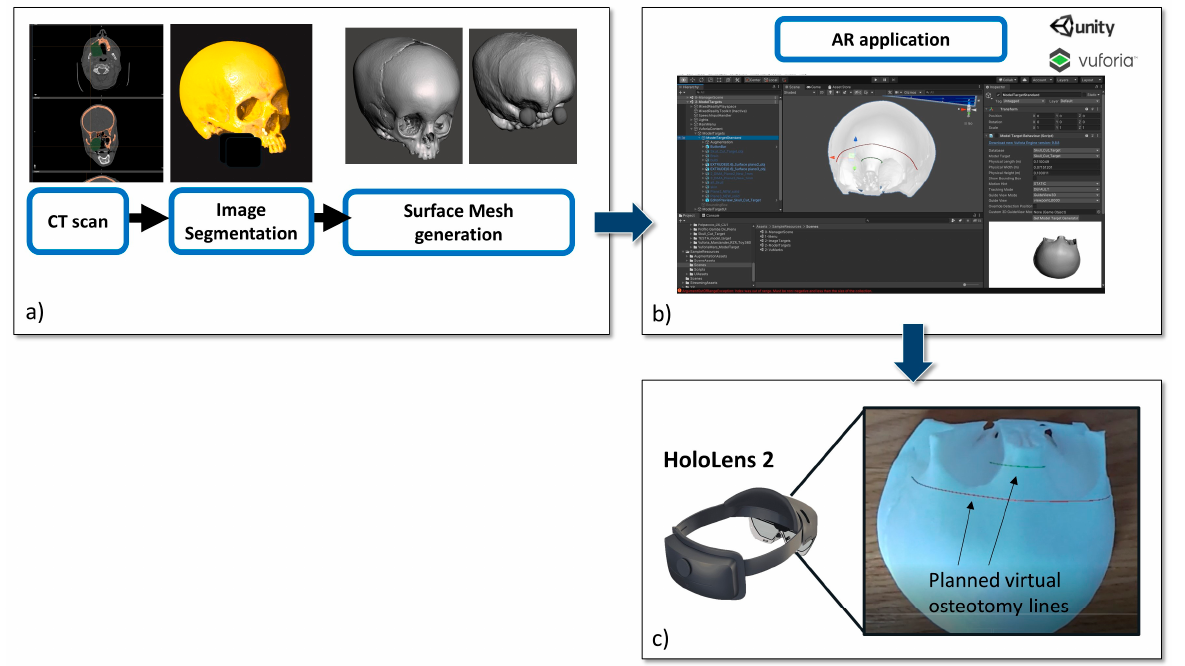
Figure 1. Development phase: ( a ) from CT scan to virtual content preparation; the virtual 3D skull model was also 3Dprinted to obtain a patient-specific phantom; ( b ) Unity software interface used for AR application development; ( c ) the planned osteotomy lines displayed in AR with HoloLens 2 smart glasses.